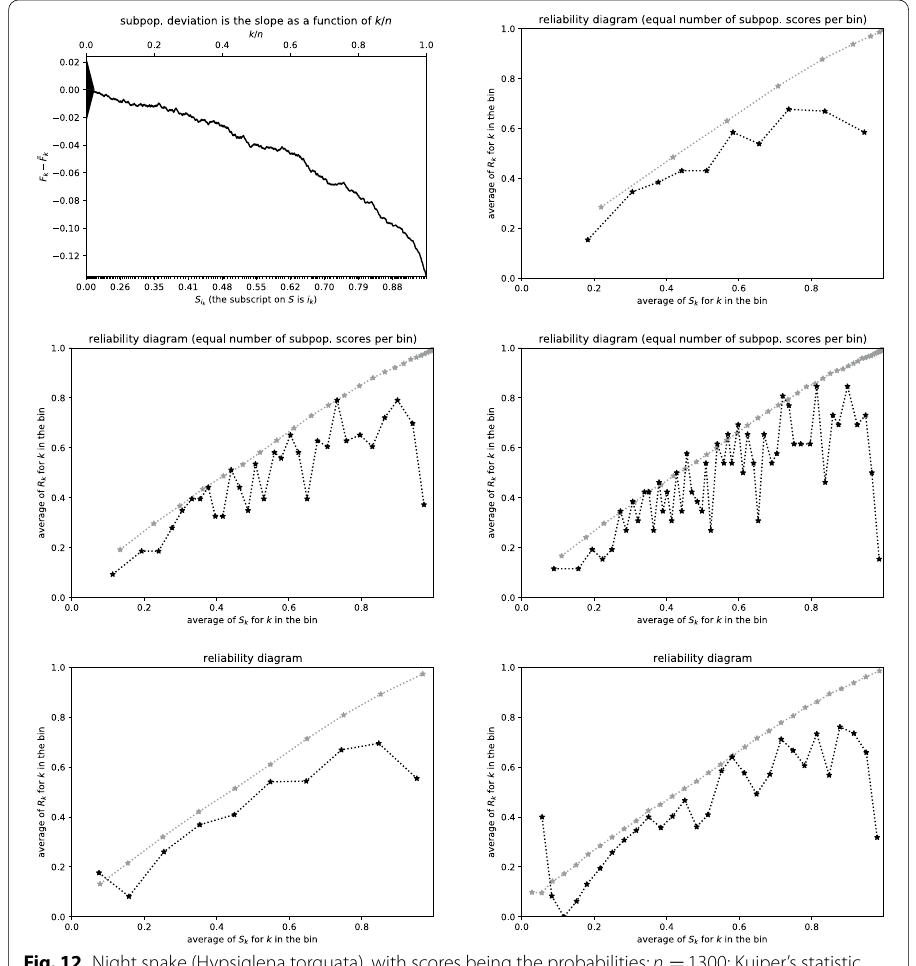
Fig. 12 Night snake (Hypsiglena torquata), with scores being the probabilities; n = 1300; Kuiper’s statistic is 0.1365 /σ = 11.35 , Kolmogorov’s and Smirnov’s is 0.1353 /σ = 11.24 . As in Figure 11, uniform resolution in the binned plots (whether with respect to observations or to scores) is insufficient. The scalar summary statistics extremely successfully detect the statistically highly significant deviation of the subpopulation from the full